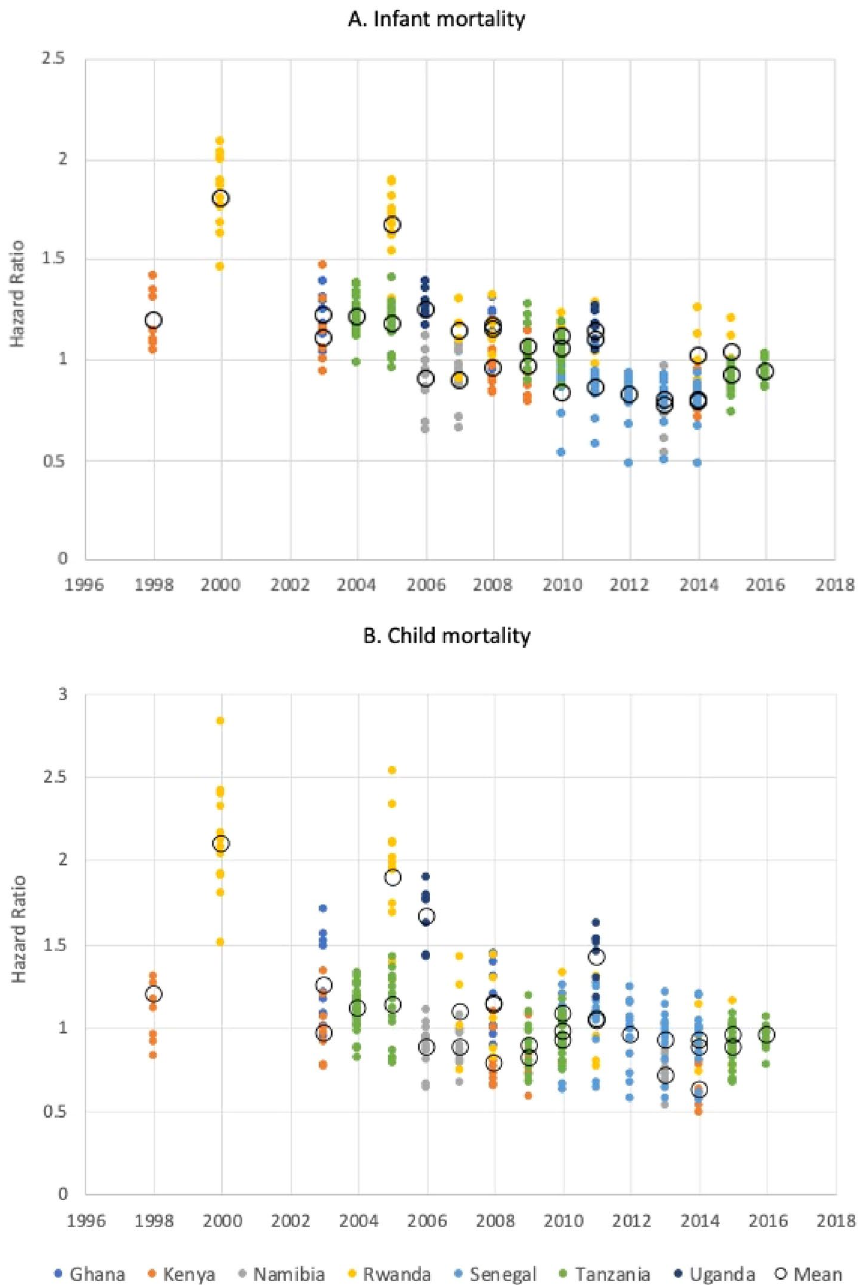
Figure 3. ( A ) Estimated hazard ratio for risk of death ( A ) before 12 months of age and ( B ) between 12 and 60 months of age over time by country (relative to the median of all